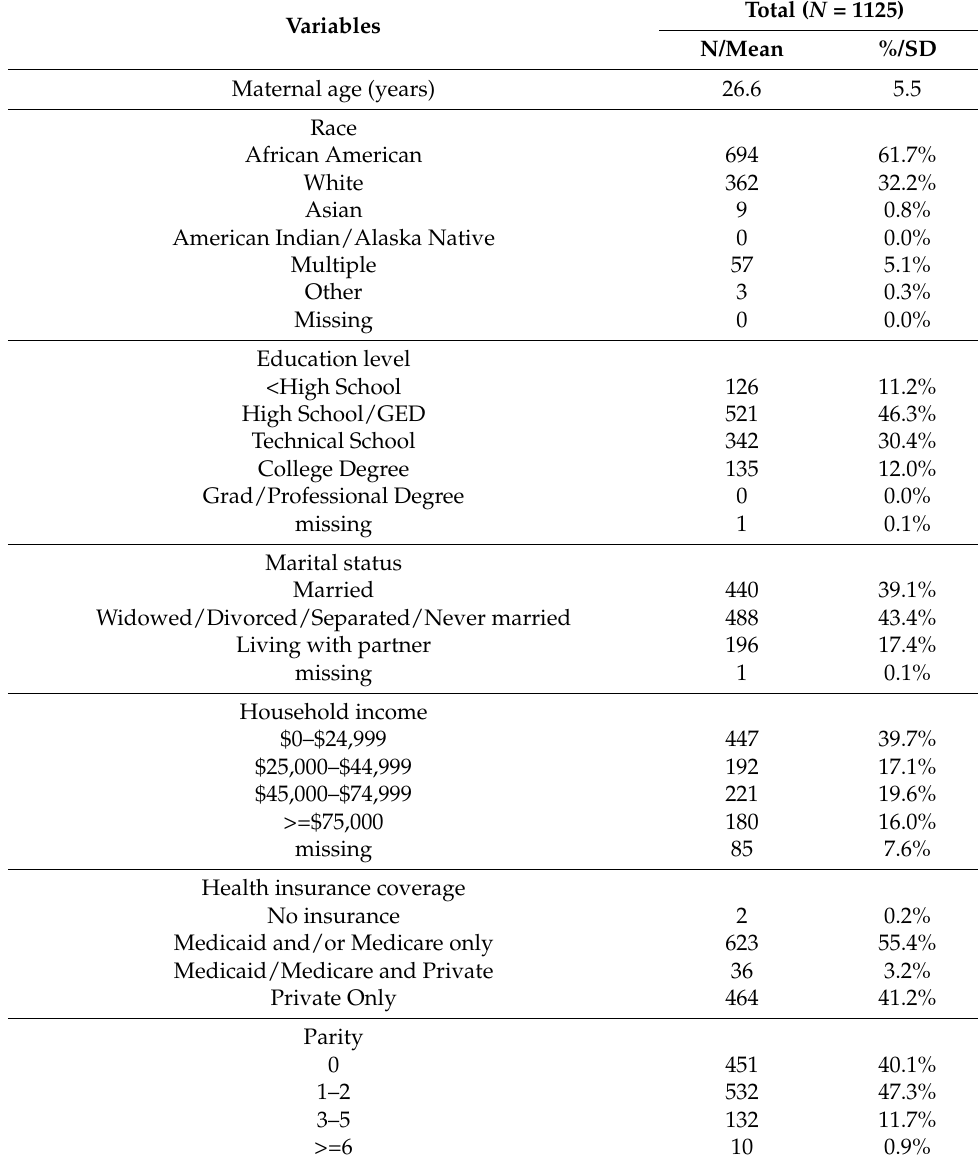
Table A1. Baseline characteristics of CANDLE participants with complete data of phthalate measure- ments in either visit and birth outcome ( N =